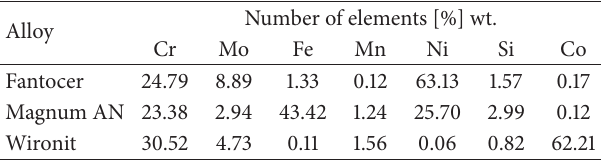
Table 1: Chemical composition of alloys used for examinations. Number of elements [%] wt. Alloy Cr Mo Fe Mn Ni Si Co Fantocer